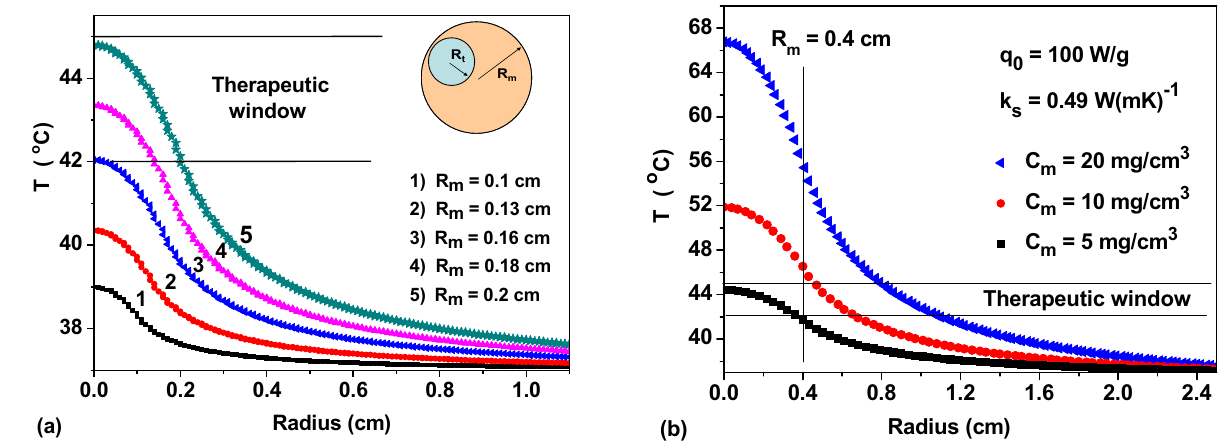
Figure 1. ( a ) The temperature distribution in the spherically symmetric model, Eq. (3), for fixed values q 0 = 100 W/g, k s = 0.49 W(mK) -1 , and C m = 20 mg/cm 3 depending on the radius of the heating region R m ; ( b ) the same for R m = 0.4 cm for various concentration of nanoparticles C m in the heating